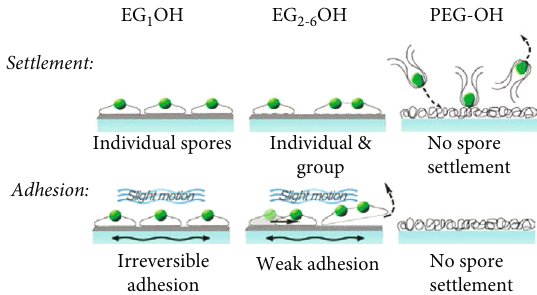
Figure 5: Schematic diagram of di ff erent reactions of spores and larvae to OEG and PEG surfaces